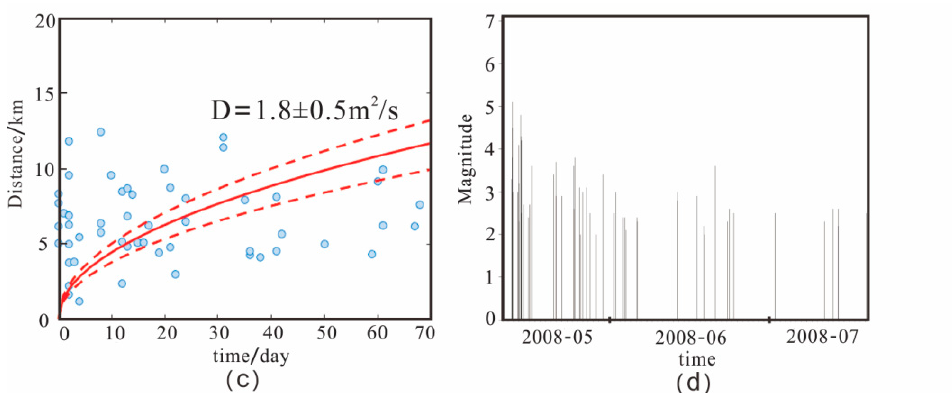
Figure 2. ( a ) The area NA. The star denotes the location of the Wenchuan mainshock, the solid black lines denote faults, F1 denotes the back fault, F2 denotes the central fault, and F3 denotes the pied- mont fault (Deng et al., 2003). ( b ) Spatiotemporal distribution of aftershocks in the area NA. The grey color represents the topography of the area. ( c ) The r–t plot for the area NA. The red lines are the envelope lines for different hydraulic diffusivities D and the blue circles denote aftershocks. ( d ) The M– t plot for the area NA.